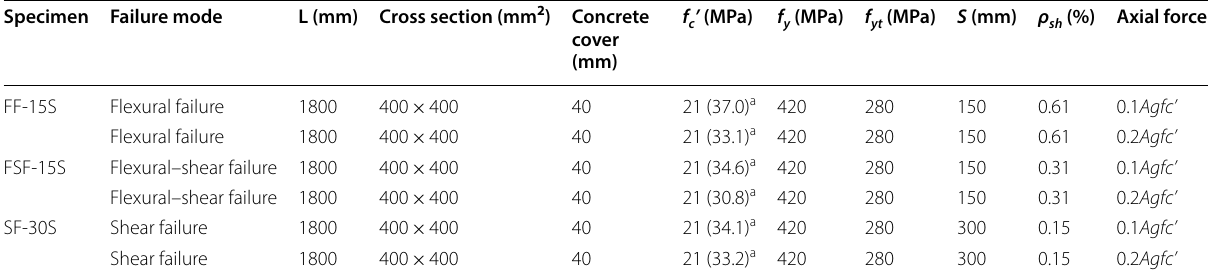
a The measured compressive strength of concrete at the testing time.